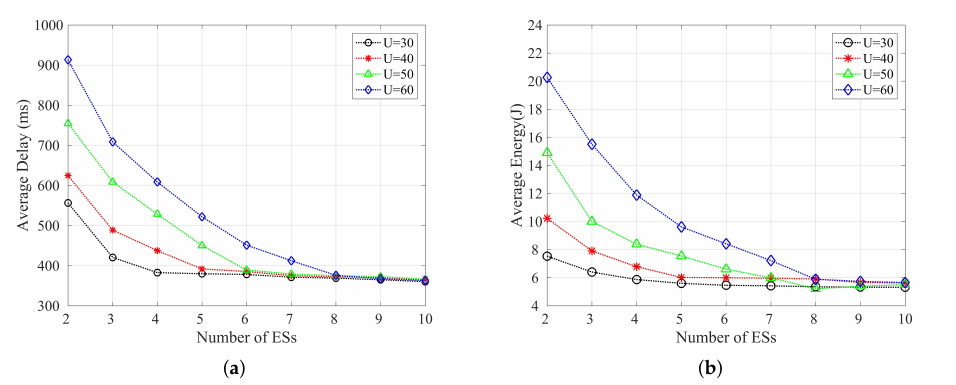
Figure 6. Variation of the average delay and the average energy consumption with the number of edge servers when the number of end devices is {30, 40, 50, 60} respectively; ( a ) Average delay; ( b ) Average energy consumption.